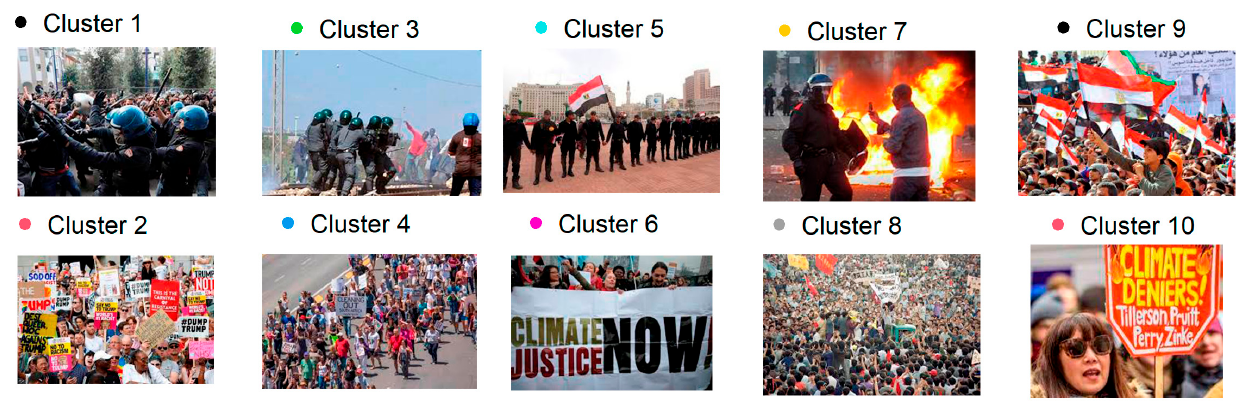
Figure 7. Images representative of each cluster .